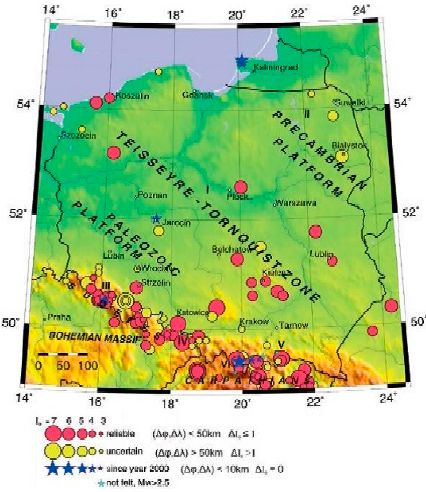
Figure 2. Seismicity in Poland since the XVI century ([28], Figure 3.1 Reprinted by permission from